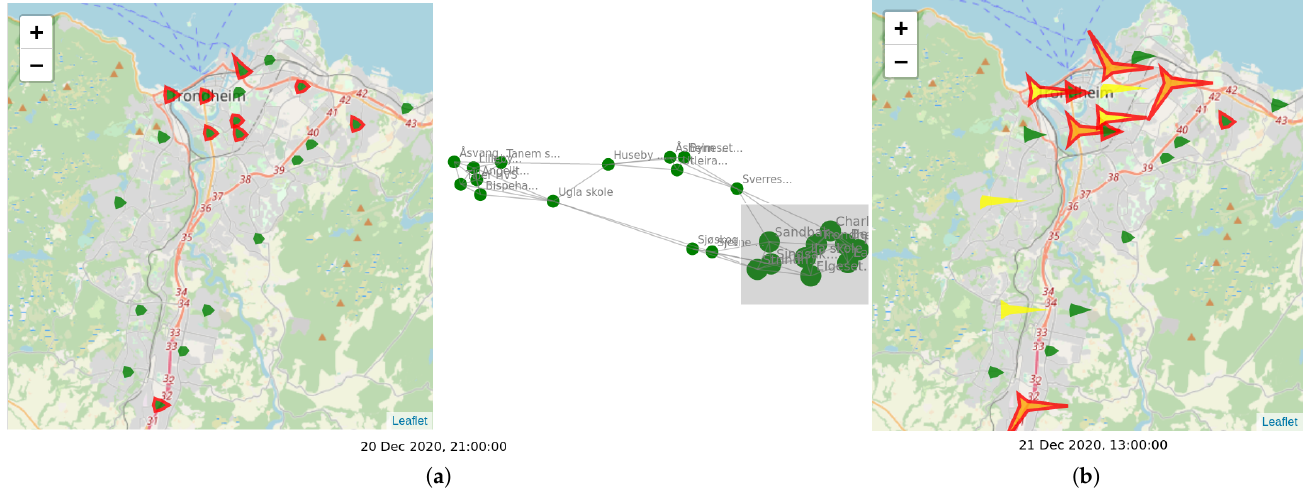
Figure 10. Example of linked graph and map visualization. ( a ) On a particular day, the graph view reveals groups of sensors with similar previous behavior. One group was selected by the user and the corresponding sensors are highlighted on the map. ( b ) A few hours later, the selected sensors exhibit similar behavior, measuring high pollutant concentrations, distinguished from the behavior of the other